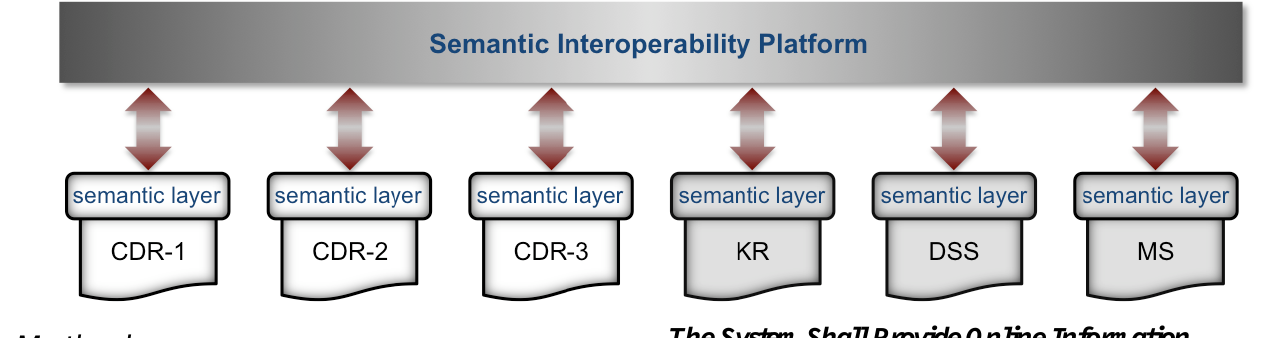
Figure 1. Architecture of the Detecting and Eliminating Bacteria Using Information Technology (DebugIT) framework. Components of the architecture, such as the clinical data repository (CDR), knowledge repository (KR), decision support system (DSS), and monitoring system (MS), are interconnected using the HTTP/SPARQL protocol through the Internet bus. Messages are transferred in the RDF format, and ontologies formalize the data model and